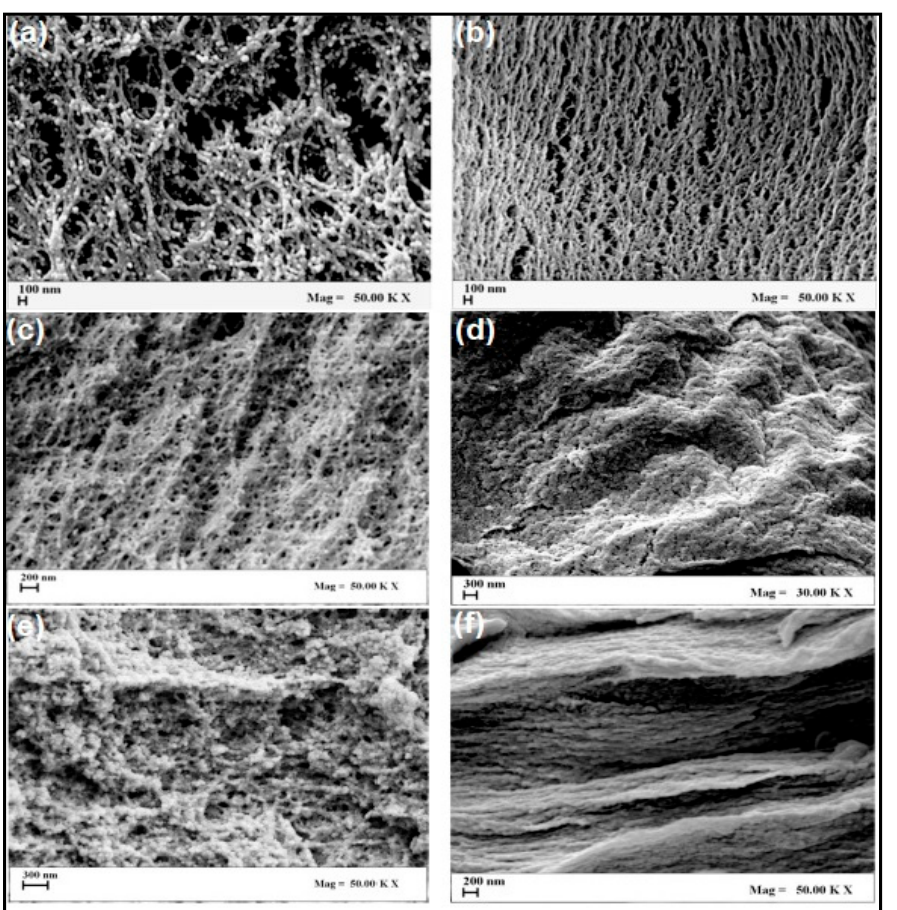
Figure 4. Internal section Scanning Electron Microscope images of: ( a ) 5% w/w Ca-Alginate aerogel, ( b ) 5% w/w Cu-Alginate aerogel, ( c ) 10% w/w Ca-Alginate aerogel, ( d ) 10% w/w Cu-Alginate aerogel, ( e ) 15% w/w Ca-Alginate aerogel, ( f ) 15% w/w Cu-Alginate aerogel. Adapted from Baldino et al. [54].